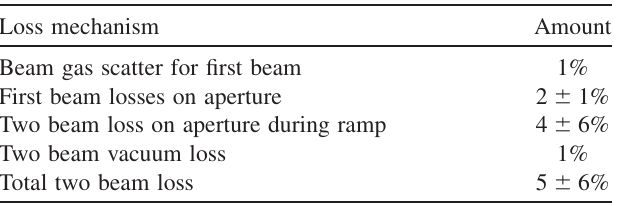
TABLE IV. Losses during the stacking and ramping process for two beams for the design stacking